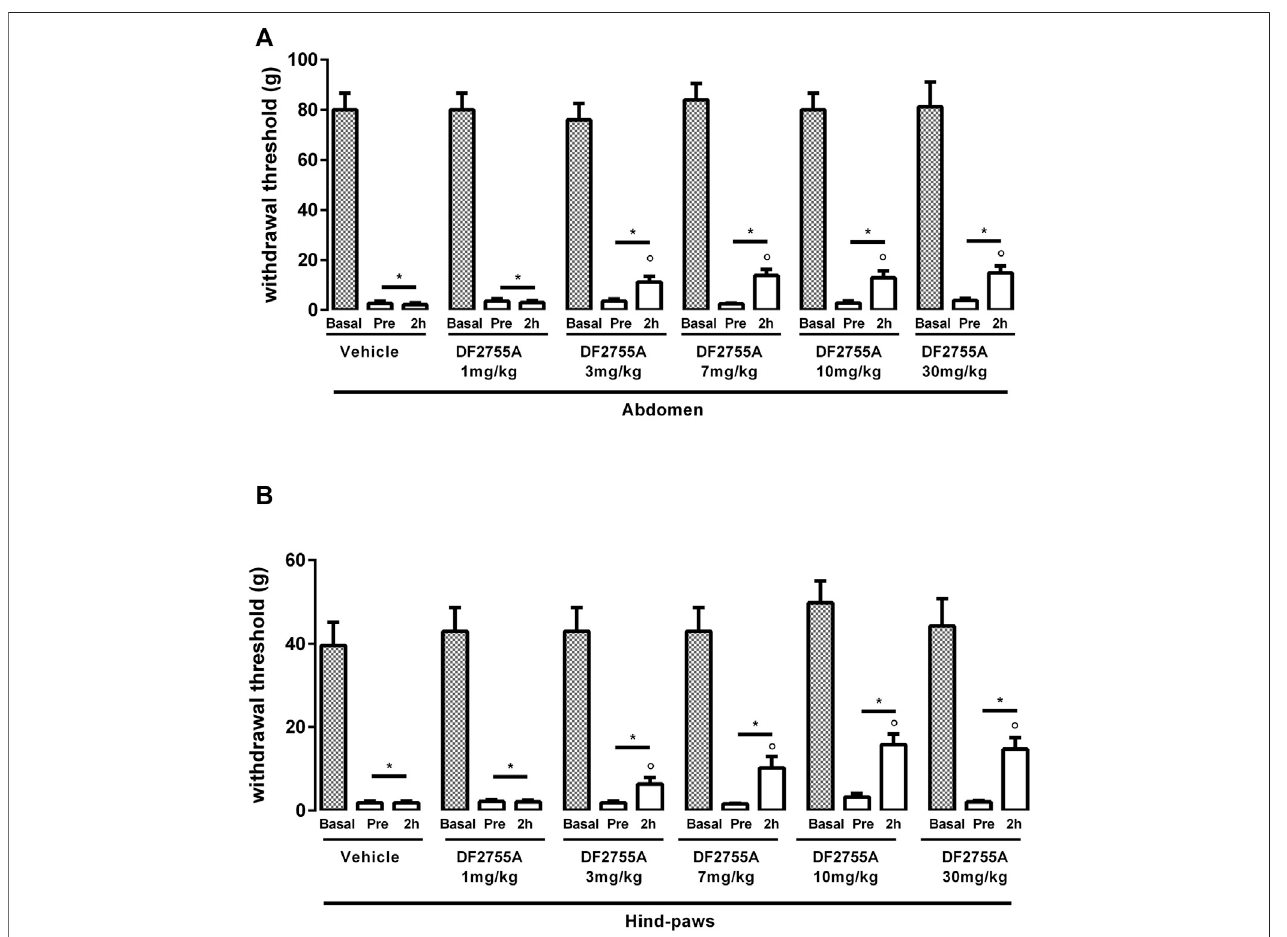
FIGURE 1 | Dose-dependent effect of DF2755A on peripheral pain in experimental non-Hunner IC. After chronic systemic i.p. injection of CYP, rats were treated p.o. with the vehicle or a single dose of DF2755A (1 – 30 mg kg-1). Mechanical nociceptive threshold was measured on the abdominal area (A) or hind paw surfaces (B) before the fi rst CYP injection (basal), 24 h after the last CYP injection and before vehicle or DF2755A treatment (pre), and 2 h after vehicle or DF2755A treatment (2 h). Datarepresentthewithdrawalthresholdandareexpressedasmeanvalues±SEM( n =10pergroup)* p < 0.05versusbasalvalues; ° p < 0.05versuspre-treatment values (one way ANOVA with Tukey ’ s